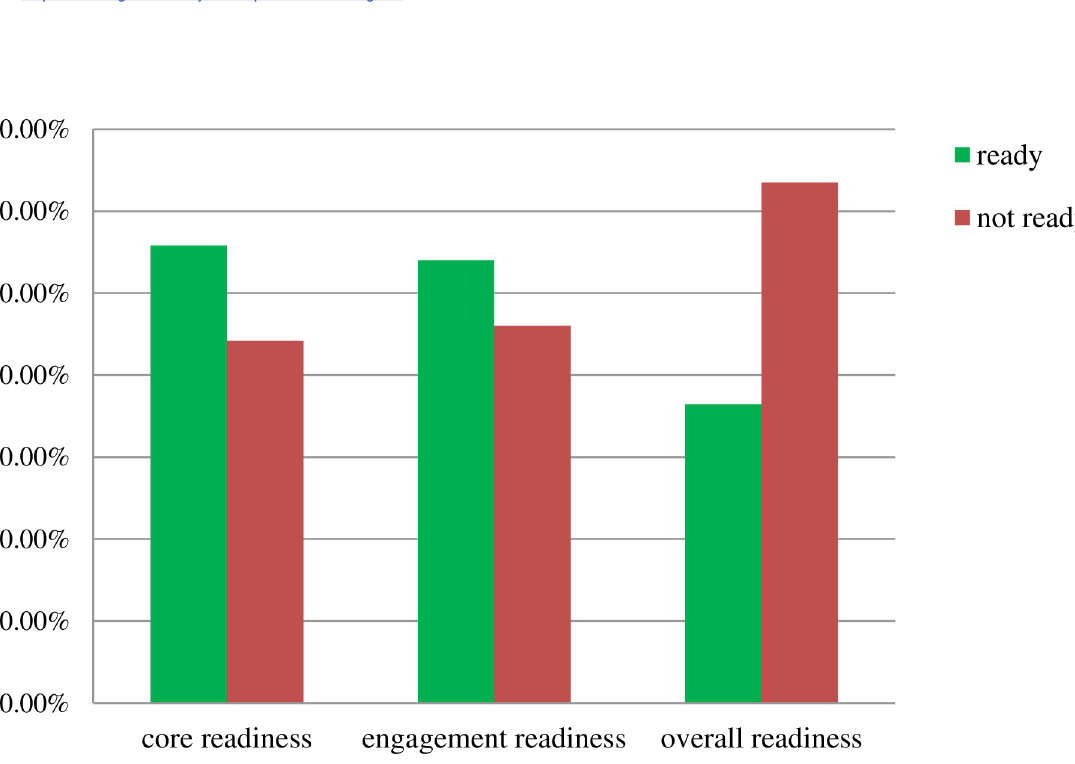
PLOS ONE | https://doi.org/10.1371/journal.pone.0276371 October 18,